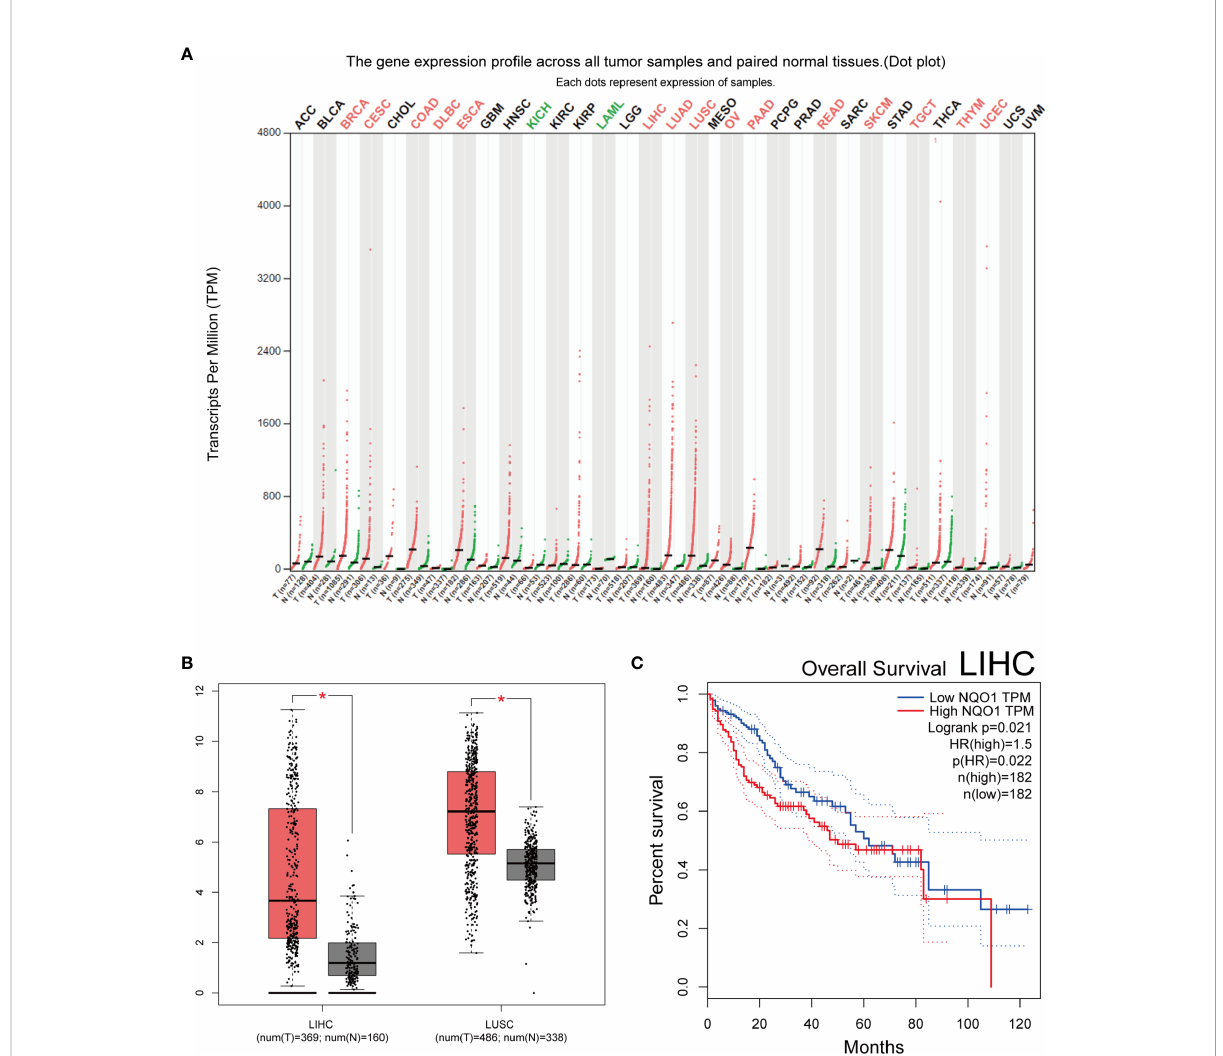
FIGURE 2 Bioinformatics study of the NQO1 gene. (A) pro fi le of the NQO1 gene ’ s expression in each tumor sample and its matched normal tissues. The expressing of NQO1 in many different types of cancer (Red represents high expression, green represents low expression, and black represents no signi fi cantly difference). (B) NQO1 gene expression in both the LIHC and the LUSC. (C) Analysis of LIHC overall survival, the expression level of NQO1 was negatively correlated with the overall survival rate of patients with LIHC. ACC, adrenocortical carcinoma; BLCA, bladder urothelial carcinoma; BRCA, breast invasive carcinoma; CESC, cervical squamous cell carcinoma and endocervical adenocarcinoma; CHOL, cholangiocarcinoma; COAD, colon adenocarcinoma; DLBC, lymphoid neoplasm diffuse large B-cell lymphoma; ESCA, esophageal carcinoma; GBM, glioblastoma multiforme; HNSC, head and neck squamous cell carcinoma; KICH, kidney chromophobe; KIRC, kidney renal clear cell carcinoma; KIRP, kidney renal papillary cell carcinoma; LAML, acute myeloid leukemia; LGG, brain lower grade glioma; LIHC, liver hepatocellular carcinoma; LUAD, lung adenocarcinoma; LUSC, lung squamous cell carcinoma; MESO, mesothelioma; OV, ovarian serous cystadenocarcinoma; PAAD, pancreatic adenocarcinoma; PCPG, pheochromocytoma and paraganglioma; PRAD, prostate adenocarcinoma; READ, rectum adenocarcinoma; SARC, sarcoma; SKCM, skin cutaneous melanoma; STAD, stomach adenocarcinoma; TGCT, testicular germ cell tumors; THCA, thyroid carcinoma; THYM, thymoma; UCEC, uterine corpus endometrial carcinoma; UCS, uterine carcinosarcoma; UVM, uveal melanoma. *:p <